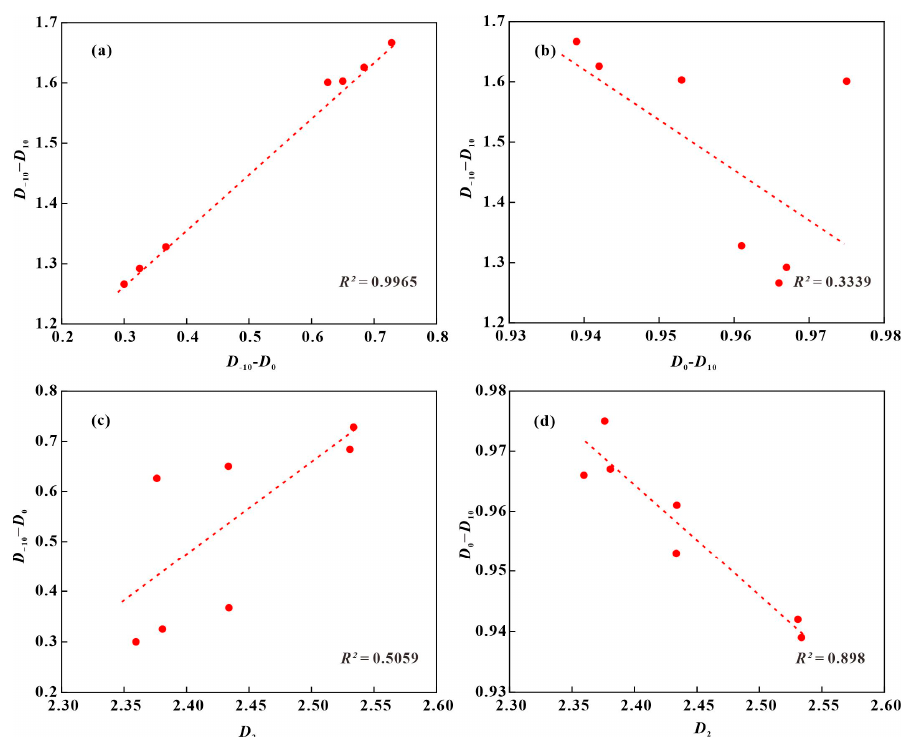
Figure 12. Analysis of single-fractal and multiple-fractal correlation: ( a ) The correlation analysis of D − 10 − D 10 versus D − 10 − D 0 . ( b ) The correlation analysis of D − 10 − D 10 versus D 0 − D 10 . ( c ) The correlation analysis of D − 10 − D 0 versus D 2 . ( d ) The correlation analysis of D 0 − D 10 versus D 2 .